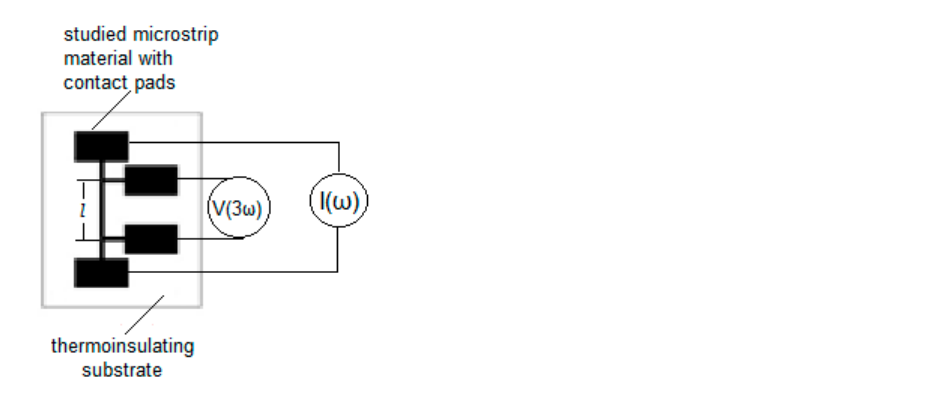
Figure 1. Schematic of the microstrip material of interest deposited on a thermal insulating substrate together with the connective contact pads, necessary for the 3 ω measurements.